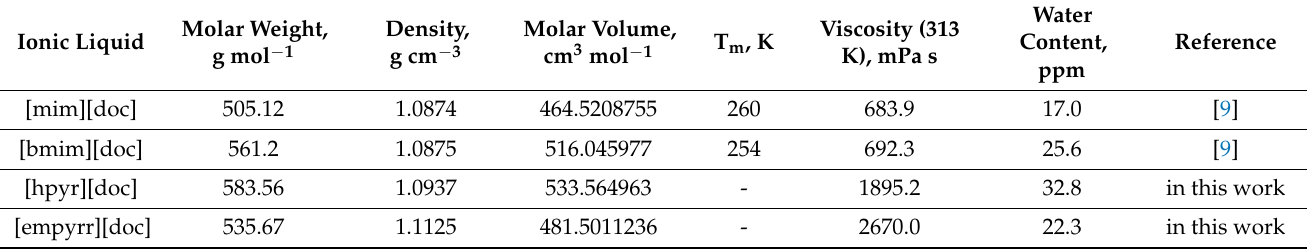
Figure 4. Viscosity of the ionic liquids as a function of temperature. Table 2. Physical properties of the [doc]-based ILs.